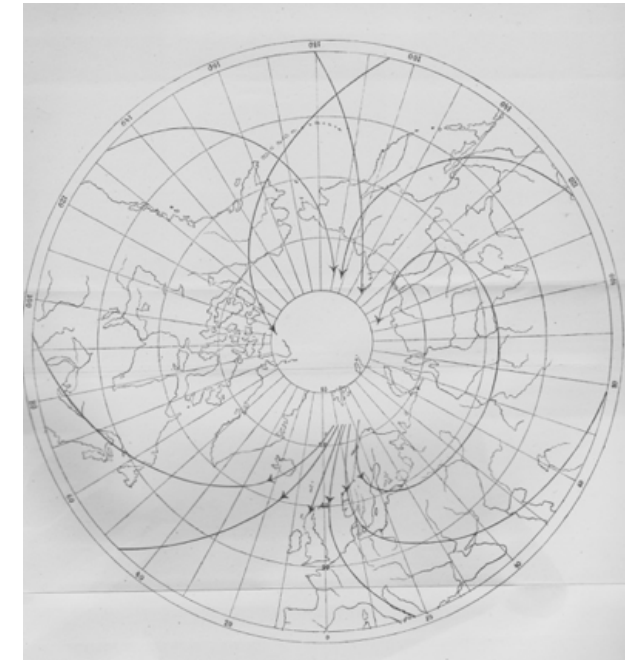
Figure 3. Convection systems of negative charges across the polar region according to Birkeland (1901).